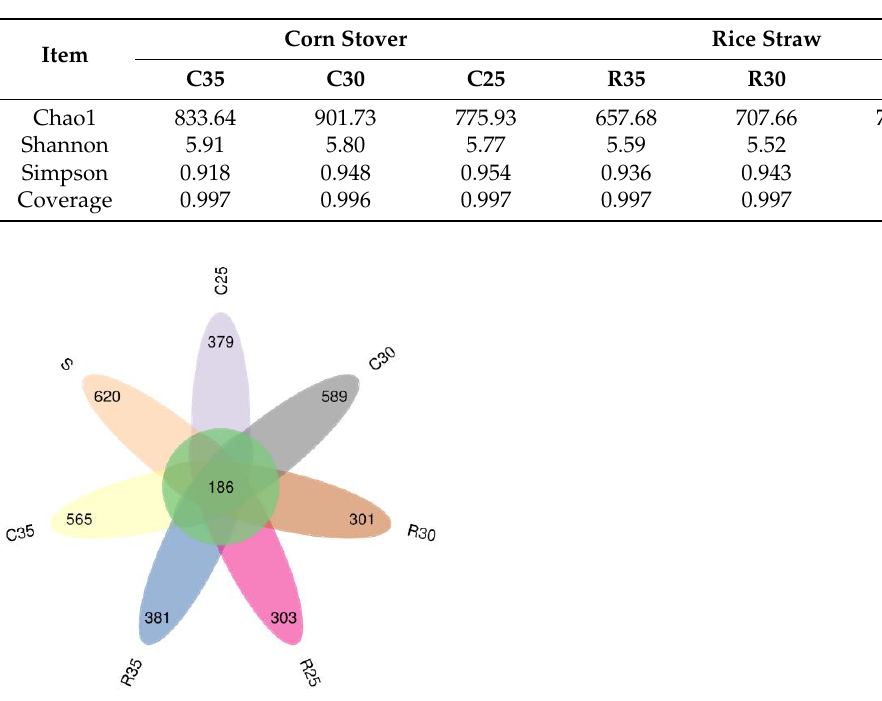
Figure 1. The Venn analysis of operational taxonomic units (OTUs) for corn stover or rice straw silage mixed with soybean curd